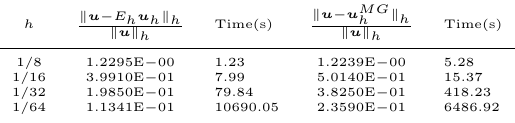
Table 4. The computational time for Experiment